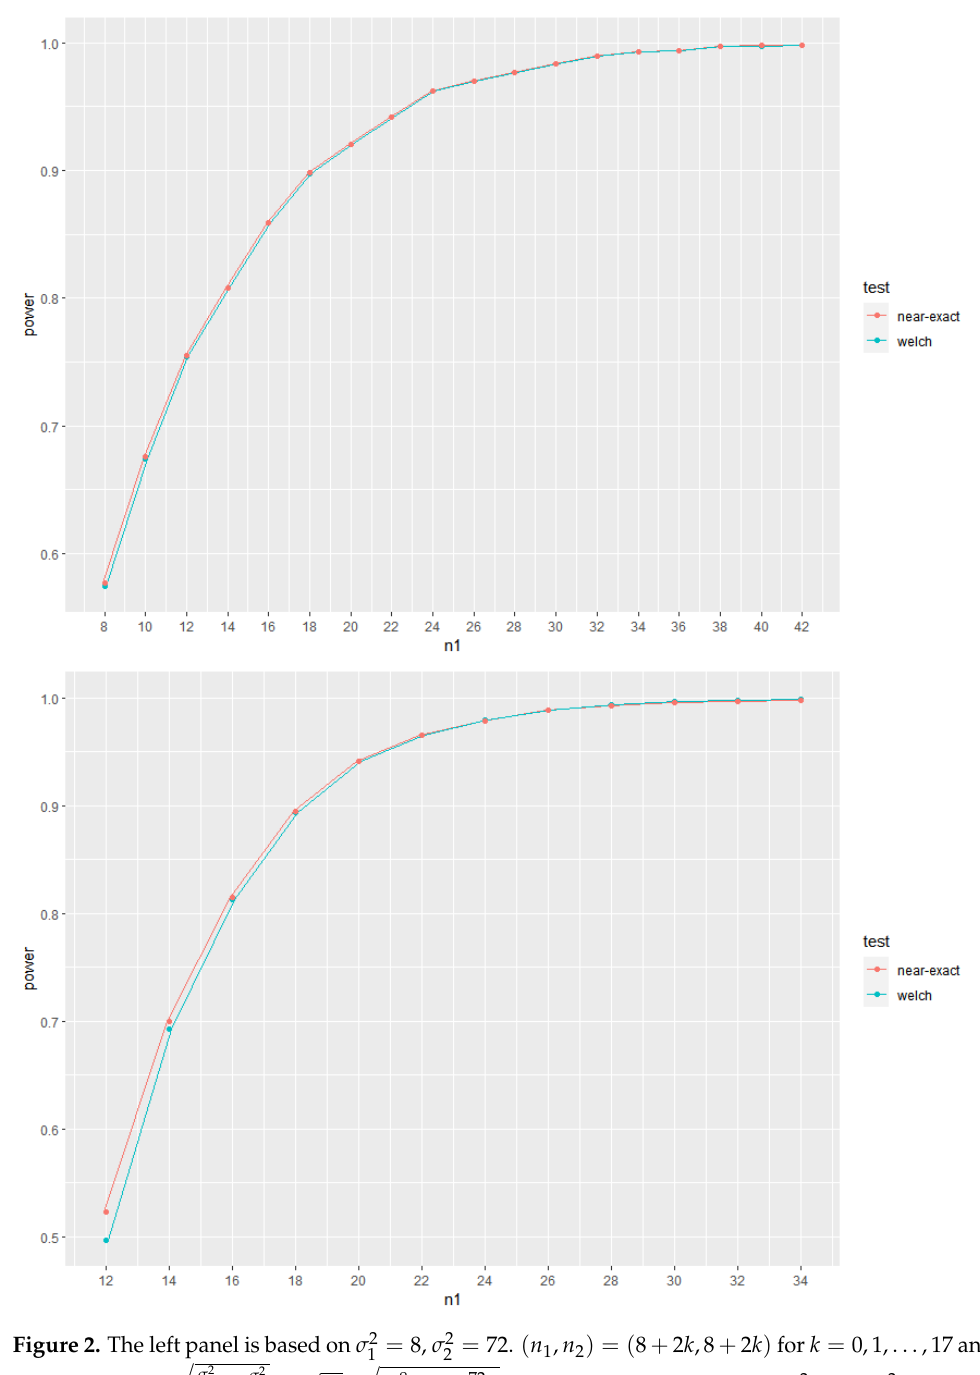
Figure 2. The left panel is based on σ 2 δ k = ( µ 1 − µ 2 ) / ( n ) = ( 12 + 2 k ,4 + 2 k ) for k = 0,1, . . . ,11 and δ 1 , n 2 Red and blue lines represent the power curves from the nearly-exact distribution and Welch’s test,